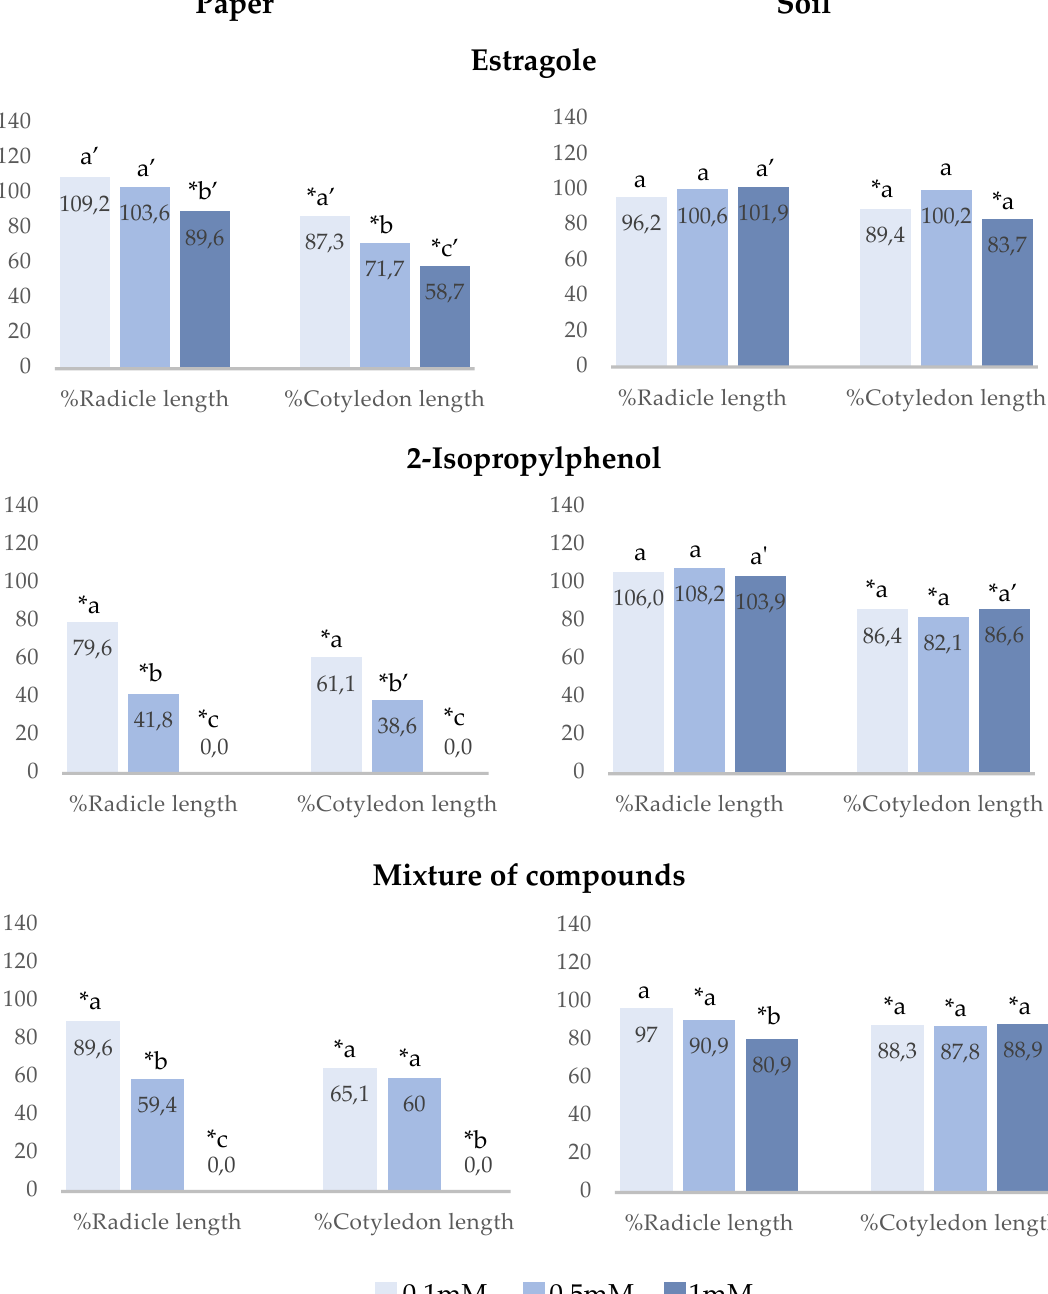
Figure 4. Effect of different concentrations of Estragole and 2-Isopropylphenol on the radicle and hypocotyl length of Lactuca sativa , expressed as the percentage relative to the control. Four replicates of each treatment were performed ( n = 4 × 50 = 200 seeds in total for each solution). * Significantly different from the controls. ’ Significantly different from the mixture of compounds. a, b, c: differences in small letters indicate significant differences between concentrations of the same index and for each treatment. p < 0.05 (Mann–Whitney